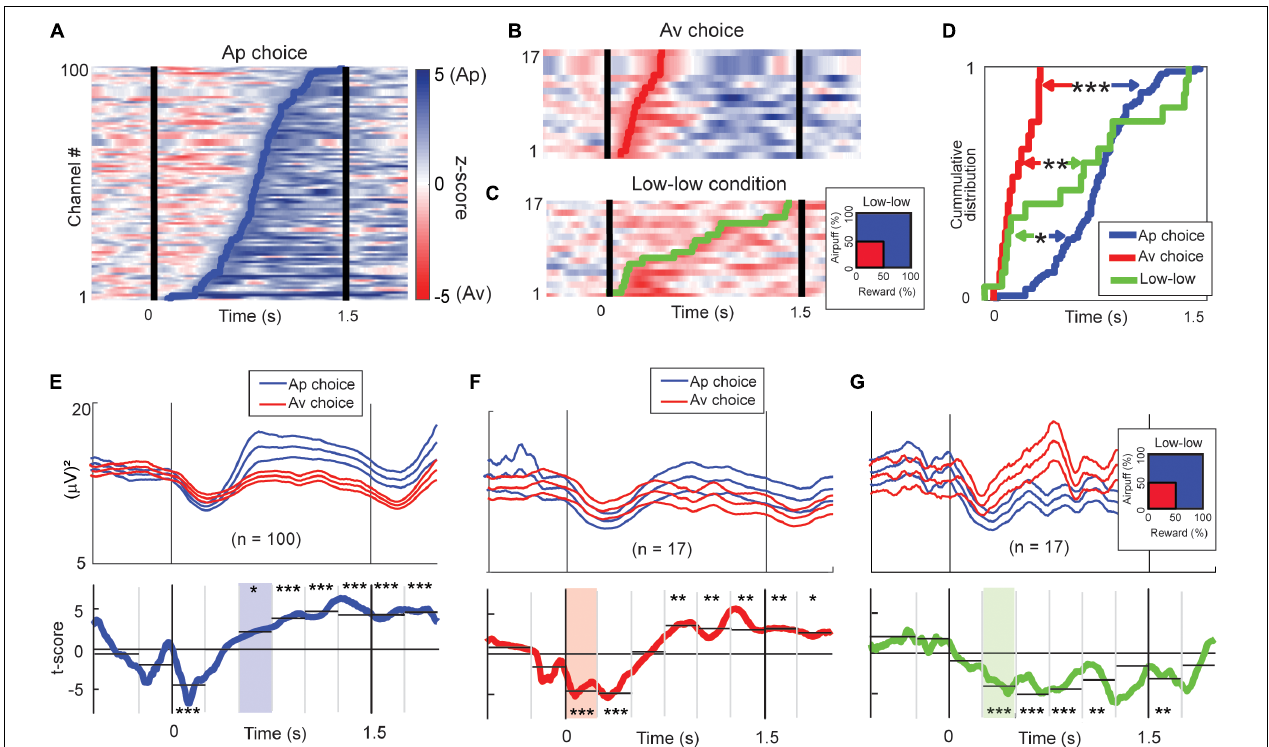
FIGURE 8 | Time-course of beta responses encoding valence and arousal. (A) The time-course of Ap–Av discrimination ability for each Ap-responding beta channel represented by z -score of the Wilcoxon rank-sum test. The z -scores are shown as pseudocolor rasters, with shades of blue indicating higher power for Ap choice, and red indicating higher power for Av choice. We defined the onset of choice discrimination as the earliest time at which the test returned P < 0.05 consecutively for more than 100 ms. The blue line indicates the onset of the increase of the beta magnitude for the Ap choice. (B) The time-course of Ap–Av discrimination ability for each Av-responding beta channel, as in (A) . The red line indicates the onset of the increase of the beta magnitude for the Ap choice. (C) The time-course of discrimination ability for different arousal conditions. The z -scores are shown with shades of blue indicating higher power for high arousal conditions, and red indicating higher power for the “low–low” condition. The green line indicates the onset of the increase of the beta magnitude for the “low–low” condition. (D) The cumulative onset times at which beta responses discriminated between upcoming Ap and Av choices or between high and low arousal levels. The onsets of increase in the magnitude for the Av choice (red line) were significantly earlier than those for the “low–low” conditions (green line; ** P < 0.01, Kolmogorov–Smirnov test) and for the Ap (blue line) choice (*** P < 0.001). The onsets of increase for the “low–low” conditions were significantly earlier than those for the Ap choice (* P < 0.05). (E) Means ( ± SEM) of the beta power time course of the Ap-responding channels (top; blue traces = Ap, red traces = Av). Two-sided t -tests were performed for the time points to show the t -scores (bottom, blue line) of the differential activity between Ap and Av choices. We aggregated the activities into 250-ms bins to derive the significance level of the discrimination (* P < 0.05, ** P < 0.01, *** P < 0.001, two-sample t -test). The light blue shows the first bin that showed a significant increase in the Ap condition. (F) Means ( ± SEM) of the beta power time course of the Av-responding channels (top; blue traces = Ap, red traces = Av). We also show the t -scores (bottom, red line) of the differential activity between Ap and Av choices (bottom). The light red indicates the first bin first, which showed a significant increase in the Av condition. (G) The group means ( ± SEM) of the beta power time course of the channels that showed an increase for the “low–low” condition (top; red traces = ”low–low”). We also show the t -scores (green line) of the differential activity for the “low–low” and other conditions (bottom). The light green indicates the first bin that showed a significant increase in the “low–low”